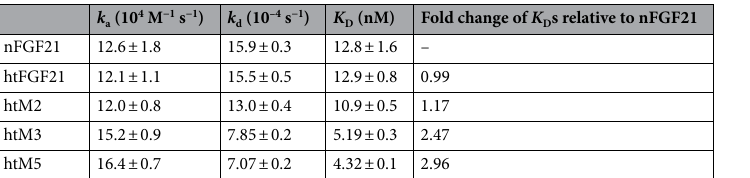
Table 1. Kinetic rate constants for β-Klotho as determined by SPR. The values were represented by mean ± SD for three independent experiments that were each